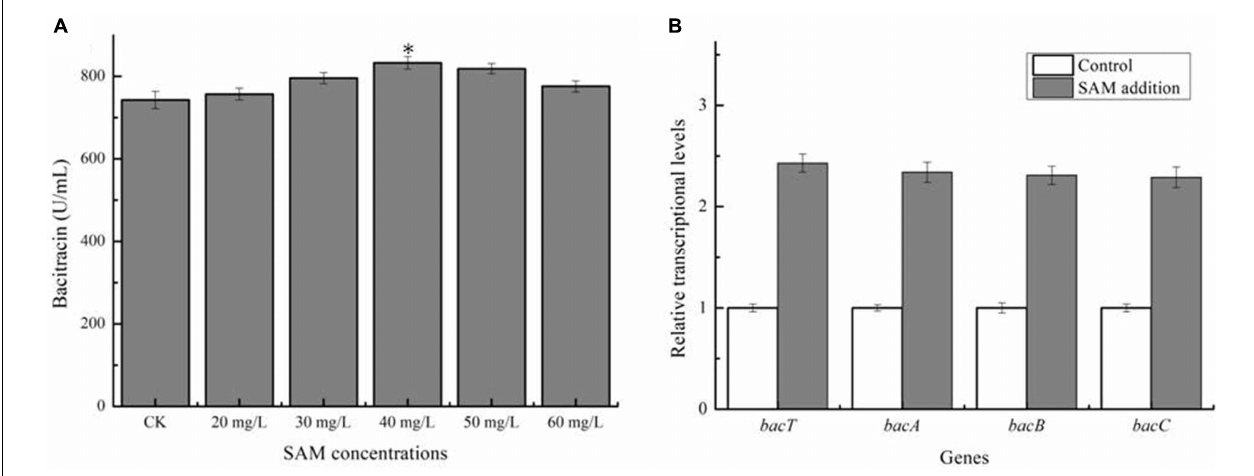
FIGURE 1 | Effects of exogenous SAM addition on bacitracin production. (A) Effects of different concentrations of SAM (20, 30, 40, 50, and 60 mg/L) additions on bacitracin yield, (B) Effects of SAM addition on the transcriptional levels of bacitracin synthetase genes bacT , bacA , bacB, and bacC . ∗ P < 0.05 and ∗∗ P < 0.01 indicate the significance levels between recombinant strains and control strain.